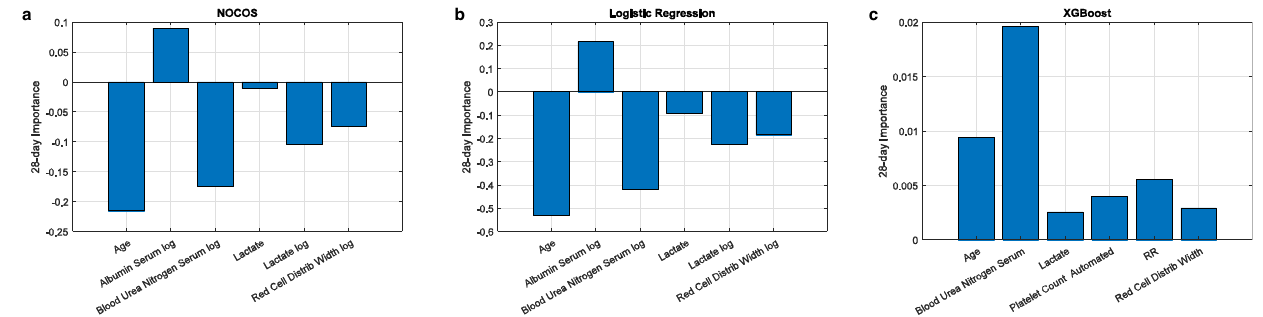
Fig.5|28-daymodelcoef fi cientimportance.a NOCOS, b logisticregression,and c XGBoost model predictor importances are plotted. The importance of the NOCOS and logistic regression model predictors are the coef fi cients of the linear predictor scaled by the standard deviations of the predictors from the